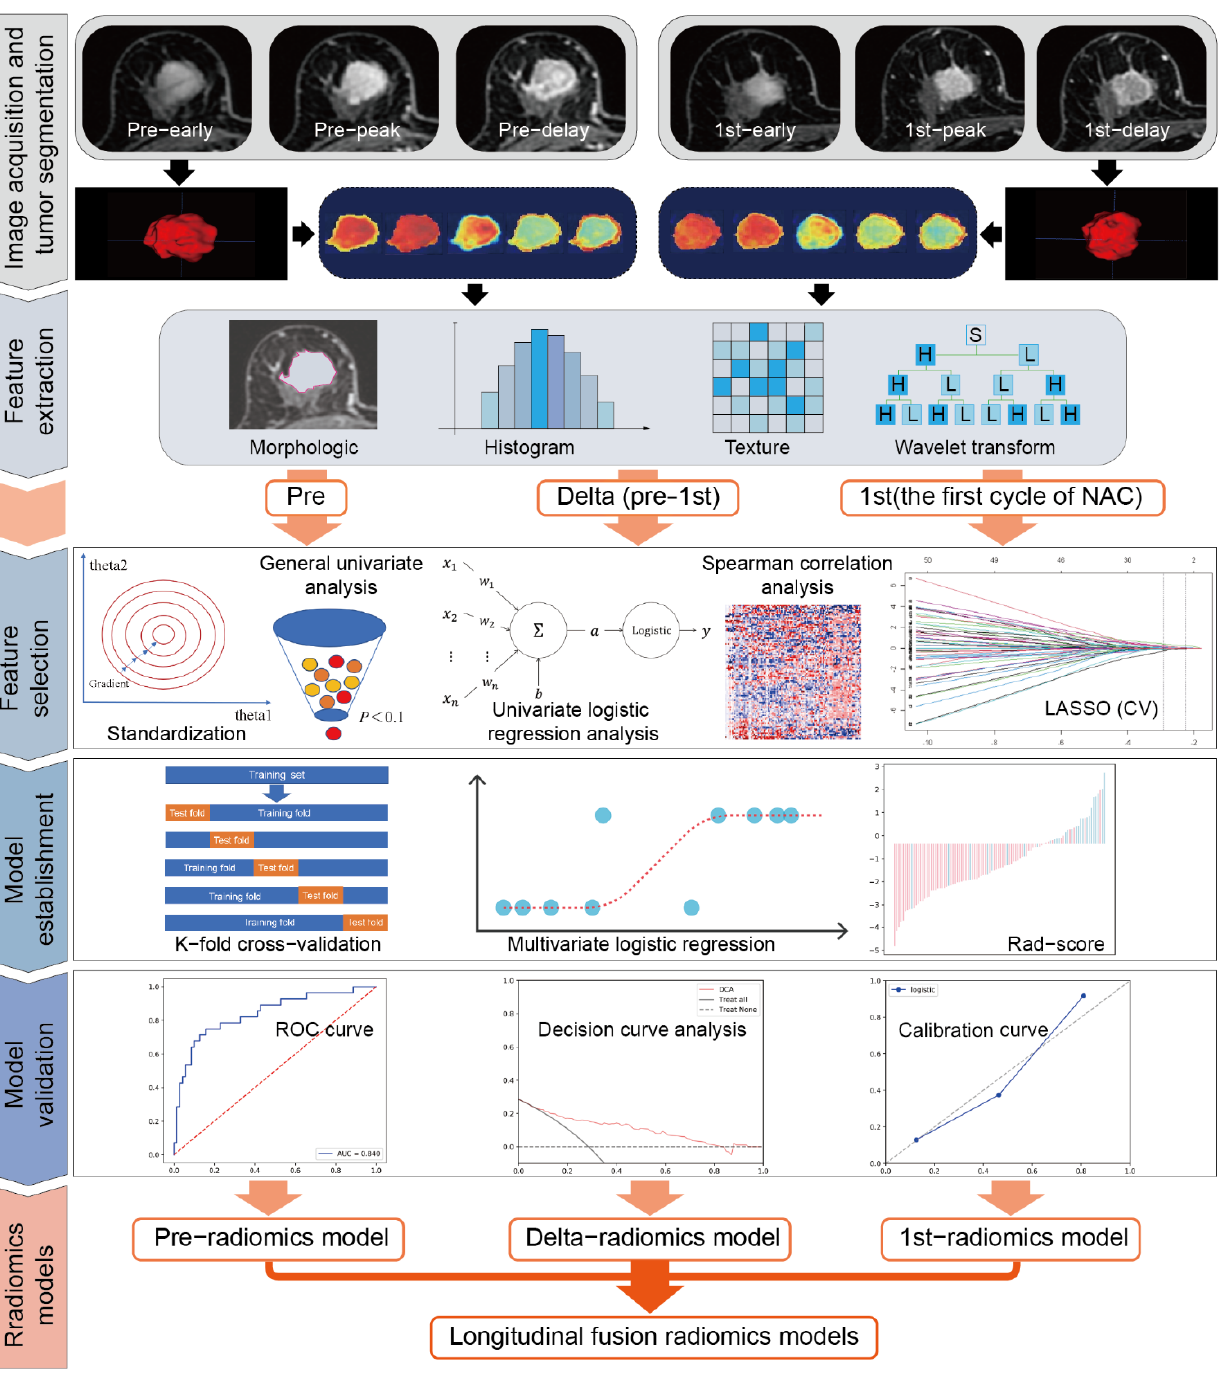
Figure 2. Workflow of the radiomics analysis. Pre, pre-NAC; 1st, the first cycle of NAC; CEe, the early phase of DCE-MRI; CEp, the peak phase of DCE-MRI; CEd, the delay phase of DCE-MRI; Delta, delta-radiomics features (the relative change values between pre- and 1st-radiomics features); LASSO, the least absolute shrinkage and selection operator; CV, cross-validation; ROC curve, the receiver operating characteristic